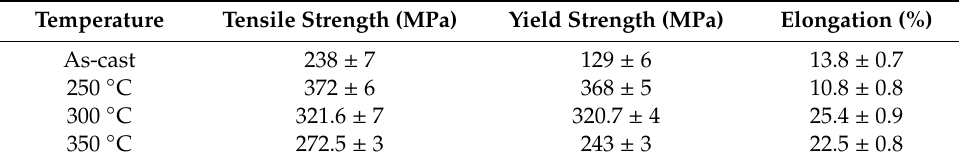
Table 2. Mechanical properties of alloys at di ff erent extrusion temperatures.